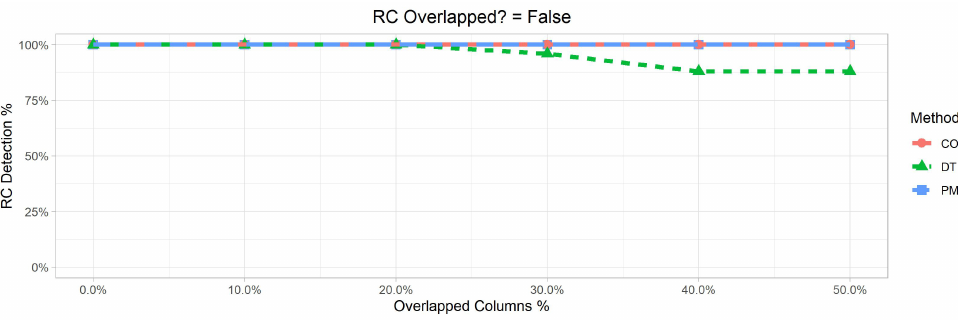
Figure 5. Results of the Mockup experiments when the root cause is not in one of the overlapped